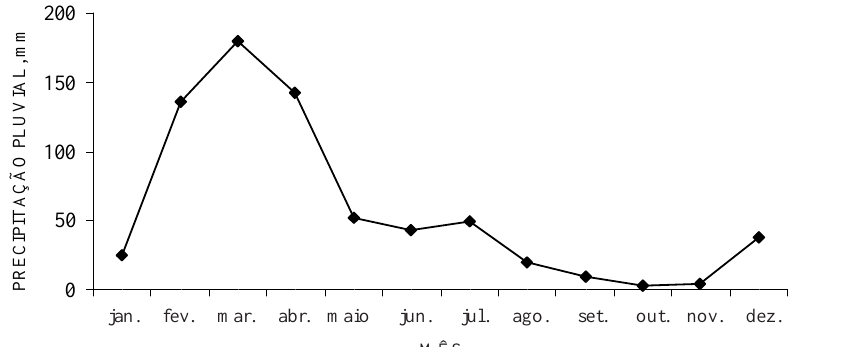
Figura 1. Distribuição temporal dos valores médios mensais da precipitação pluvial em Sumé